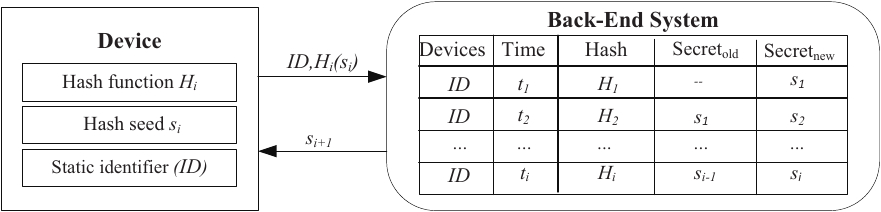
Figure 3. Illustration of synchronous secrets.